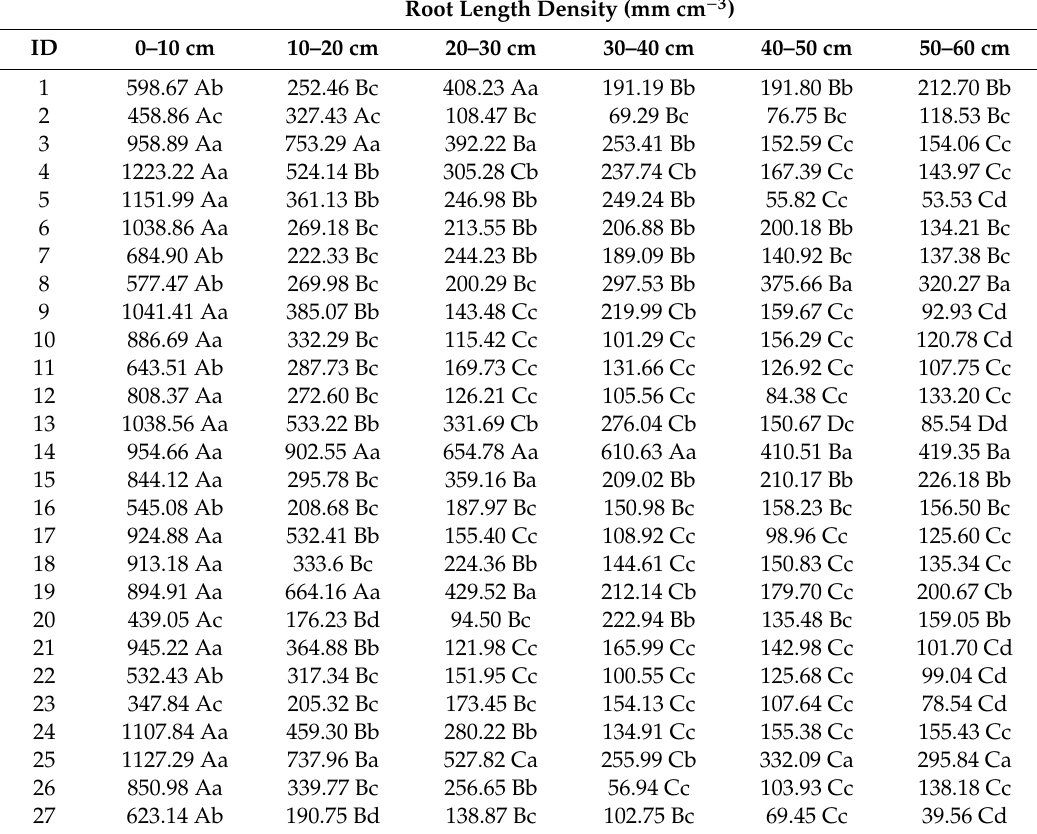
Table 3. Average root length density of 43 C. canephora genotypes in six soil